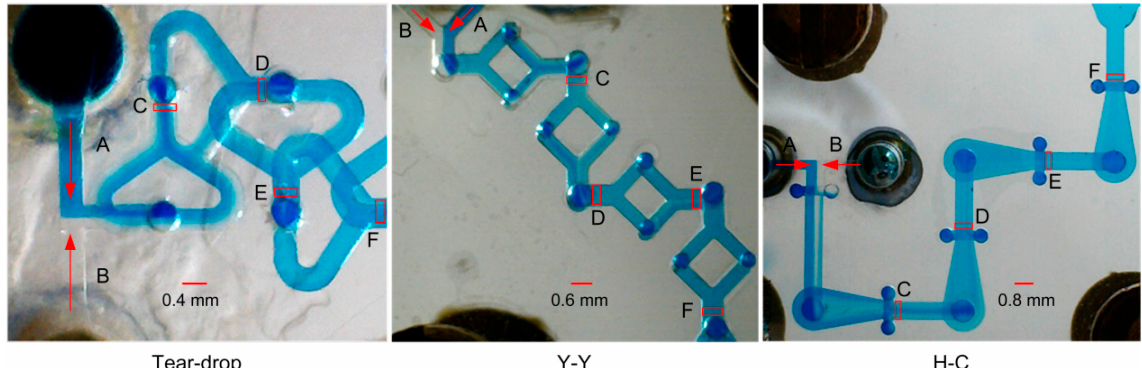
Figure 5. Micromixers after filling with fluids at Re = 1.